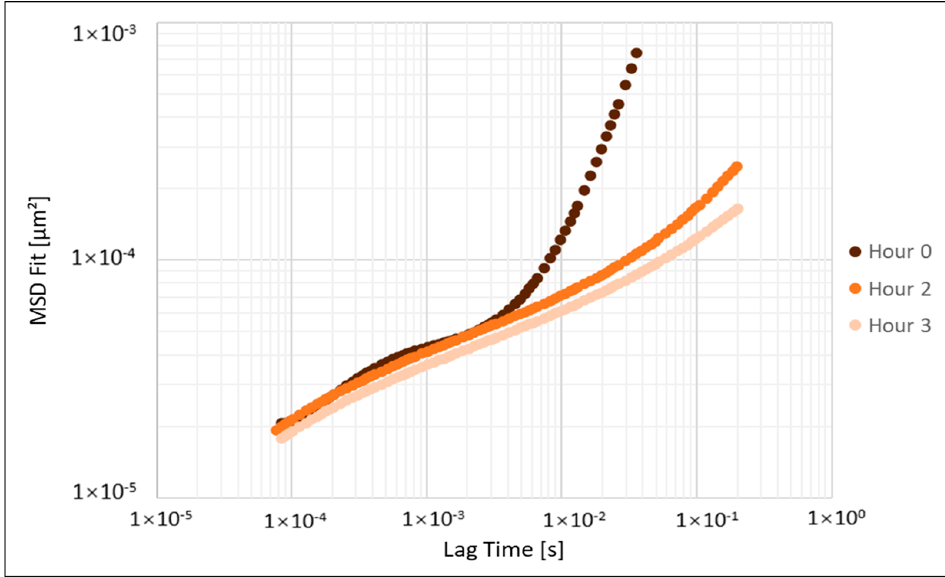
Figure 4. 3.7 wt % CAPB, 3.7 wt % SLES, 15 wt % jojoba oil emulsion variation in MSD values over a 3-h period.